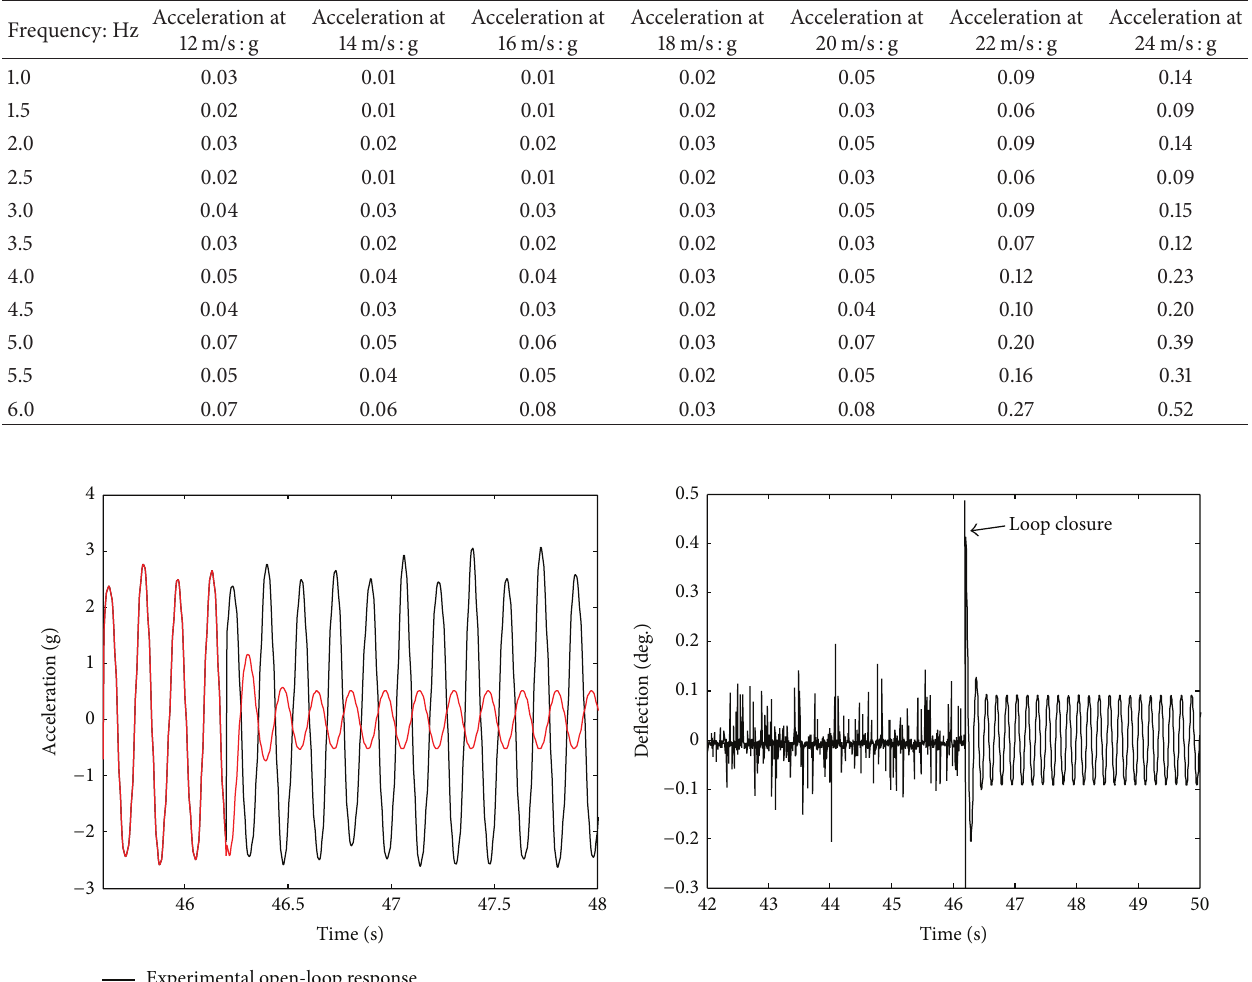
Table 6: Gust response alleviation result for varying frequencies and varying velocities.